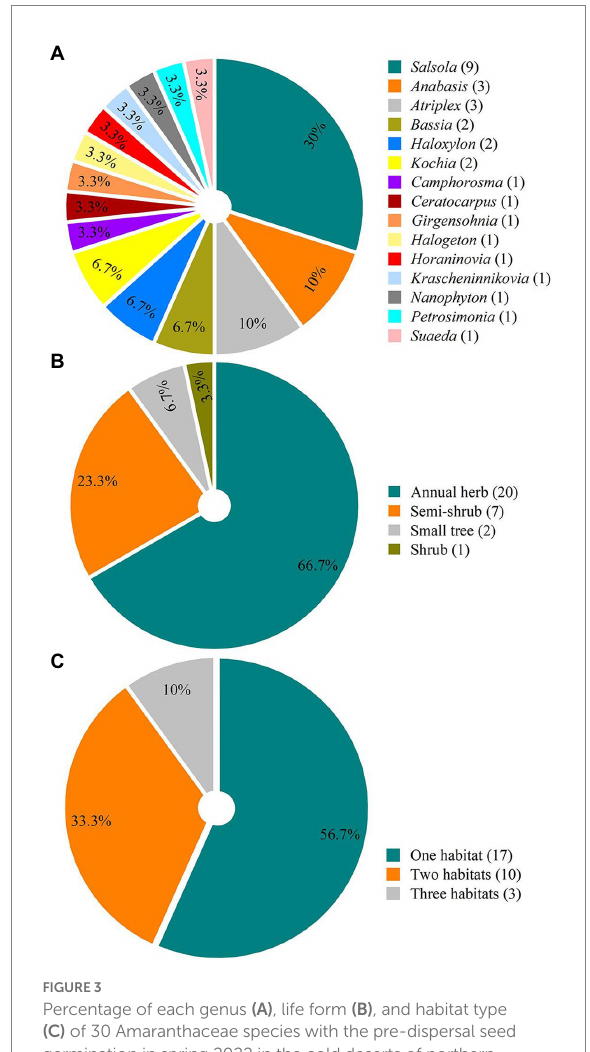
FIGURE 3 Percentage of each genus (A) , life form (B) , and habitat type (C) of 30 Amaranthaceae species with the pre-dispersal seed germination in spring 2022 in the cold deserts of northern Xinjiang. Number in parenthesis beside each legend indicates number of